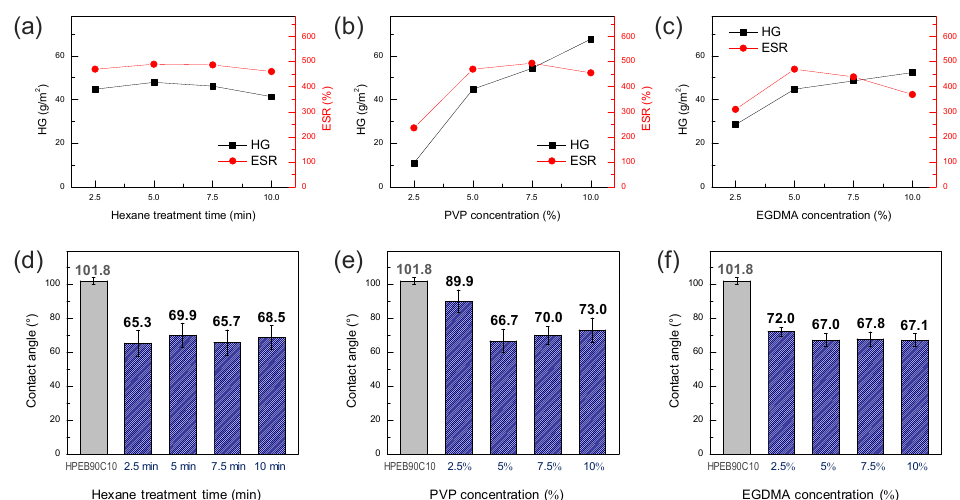
Figure 6. ( a ) Hydrogel amount (HG) values and equilibrium swelling ratio (ESR) values of the PVP hydrogel formed on the HPEB90C10 film as a function of ( a ) the hexane treatment time, ( b ) PVP concentration, ( c ) EGDMA concentration. Water contact angle values of PVP hydrogel-modified HPEB90C10 as a function of ( d ) the hexane treatment time, ( e ) PVP concentration, ( f ) EGDMA concentration.